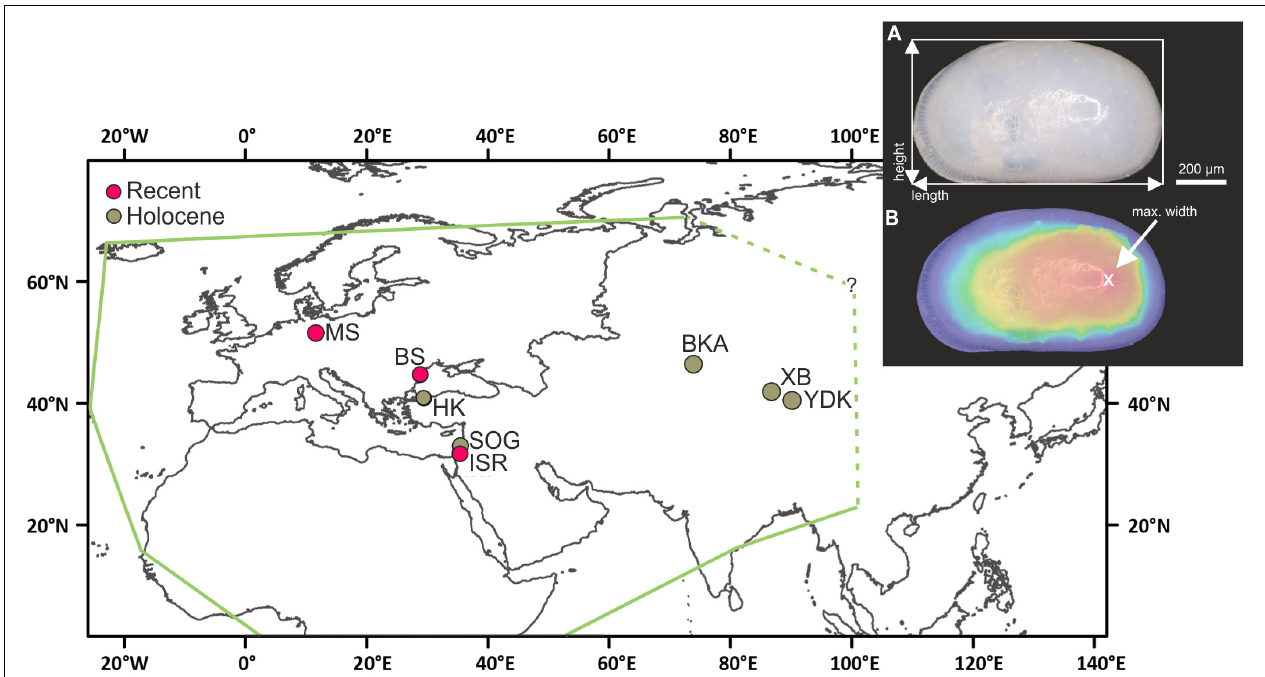
FIGURE 1 | Map of the Eurasian realm, showing the localities (YDK, Tarim Basin, China; XB, Lake Bosten, China; BKA, Lake Balkhash, Kazakhstan; ISR, Dead Sea, Israel; SOG, Sea of Galilee, Israel; BS, Danube Delta, Romania; HK, Hersek lagoon, Turkey; MS, Mansfeld Lakes, Germany) of investigated Cyprideis valves and the geographical range of Cyprideis torosa according to Wouters (2017) (green line). Inset displays measured size traits on Cyprideis valves. Length and height were measured as maximum extension of the valve outline (A) . Valve width was obtained as maximum height of focus-stacked photographs (B) . Displayed are female left valves, measurements were, however, identical for male left and right